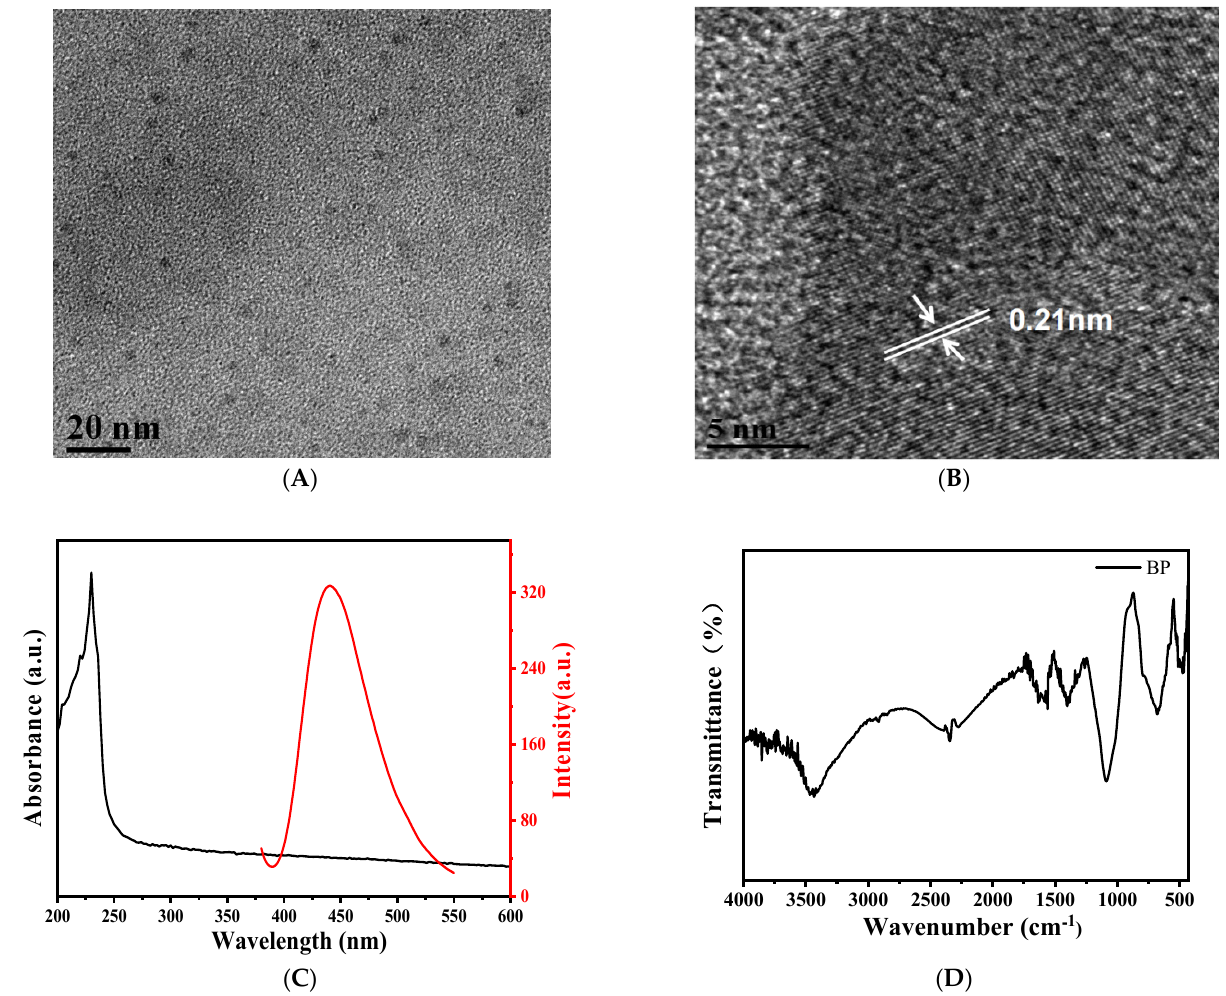
Figure 2. ( A , B ) TEM image, ( C ) UV-Vis absorption spectrum and fluorescence spectrum, ( D ) FTIR of BPQDs.